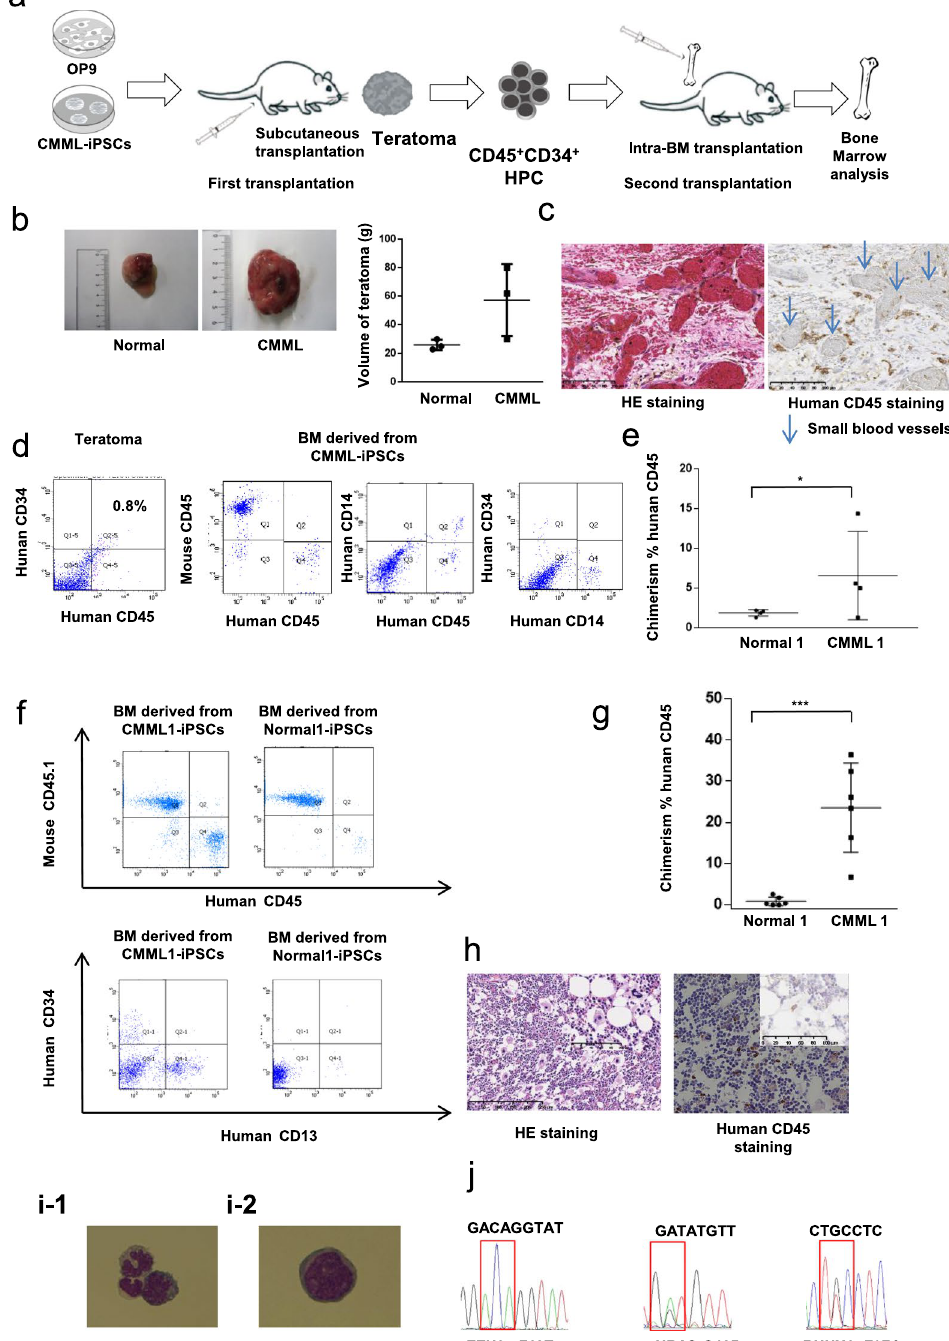
Figure 4. In vivo CMML xenograft model recapitulate its pathogenesis. ( a ) Experimental scheme for the first transplantation. We co-injected CMML-iPSCs along with OP9 stromal cells into immunodeficient mice using an in vivo system in which human CMML iPSCs develop into HPCs within teratomas. Second transplantation of CMML progenitor cells generated in vivo . ( b ) CMML iPS-induced teratomas had larger volumes than the induced teratomas from Normal-iPSCs ( n = 3, independent experiments, Normal-iPSCs1 from a healthy donor, and CMML-iPSCs 1 from a CMML patient, paired two-sided t -test). ( c ) Immunostaining of CD45 + blood cells around the small blood vessels generated in the teratoma. ( d ) CD45 + CD34 + HPCs were isolated from the teratoma. Leakage of the CD45 + CMML cells from the teratoma into the BM was observed. ( e ) Estimated number of CMML cells in the BM of engrafted mice in which teratomas formed from tCMML iPS cells ( n = 4, independent experiments, * p < 0.05, Normal-iPSCs1 from a healthy donor, and CMML-iPSC1 from a CMML patient, paired two-sided t -test). ( f ) CMML-iPSC-derived blood in vivo reproduced and recapitulated the profiles of CMML surface antigens, CD13 + or CD34 + . ( g ) Flow cytometry revealed human chimerism of CD45 + cells in the BM of the secondarily transplanted NSG mice. Statistical analysis was performed ( n =